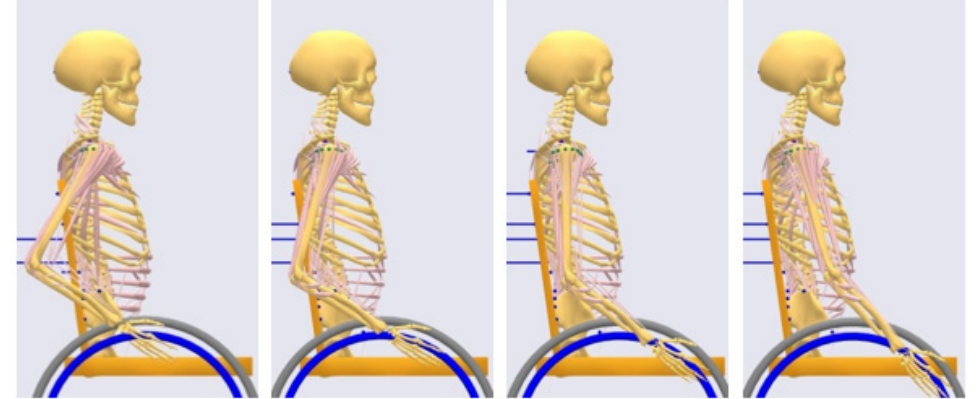
Figure 9. Simulation of movement and human muscle forces when propelling a wheelchair with the Wheelchair Cam-thread Drive (WCD).